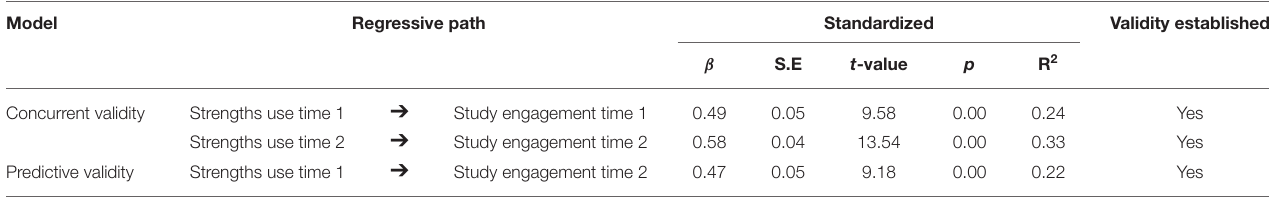
TABLE 9 | Concurrent and predictive validity of the second-order strengths use model on study engagement.